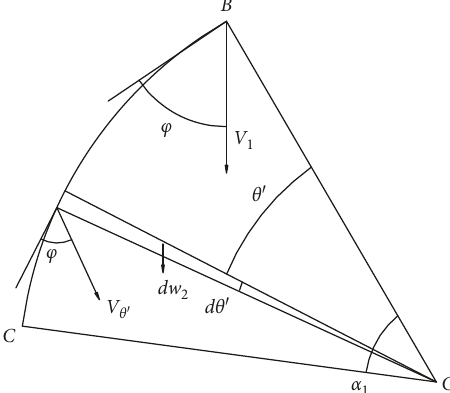
Figure 3: Schematic diagram of the power calculation of circular shear zone BGC